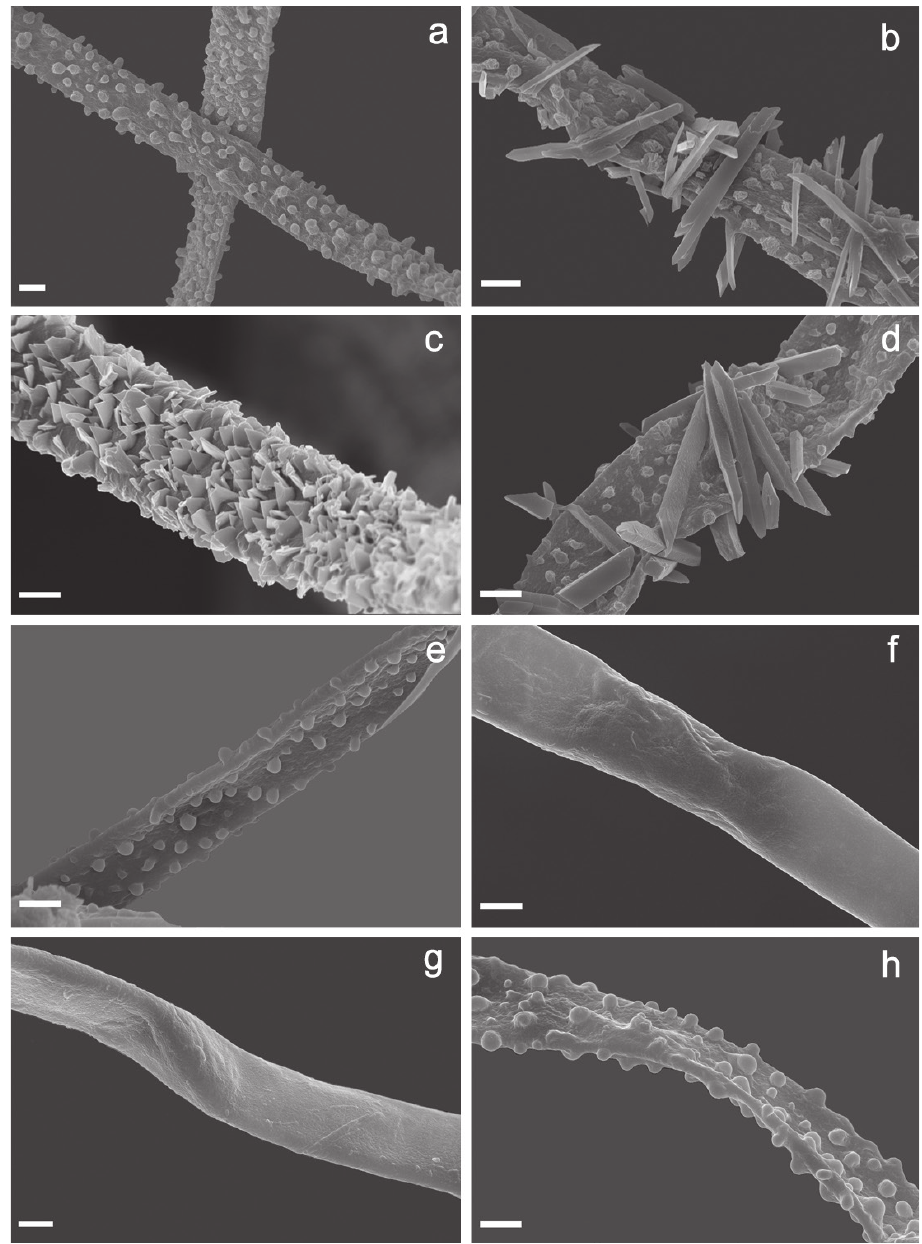
Figure 5. Hyphae of basal mycelium from Clavariadelphus under SEM. a C. alpinus (HKAS 57396, holotype) b C. amplus (HKAS 54876, holotype) c C. elongatus (HKAS 76589) d C. gansuensis (HKAS 76487, holotype) e C. himalayensis (HKAS 58811) f, g C. sachalinensis ( f from HKAS 33844; g from MHHNU 7816) h C. yunnanensis (HKAS